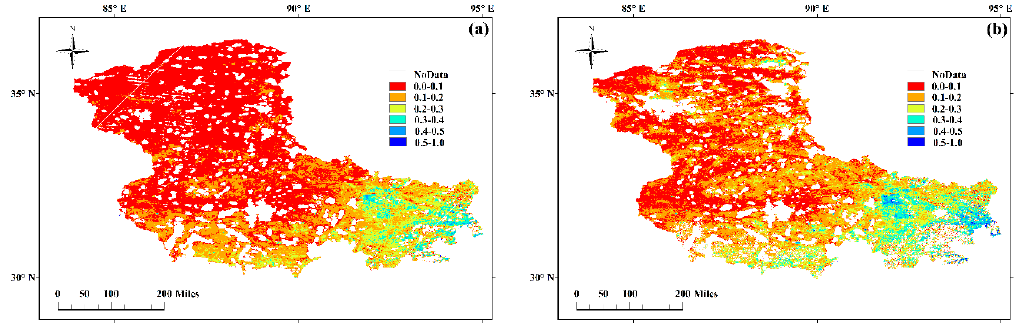
Figure 14. Soil moisture map at 1 km resolution over the Naqu City study area on ( a ) 5 August 2013 and ( b ) 6 September 2013.